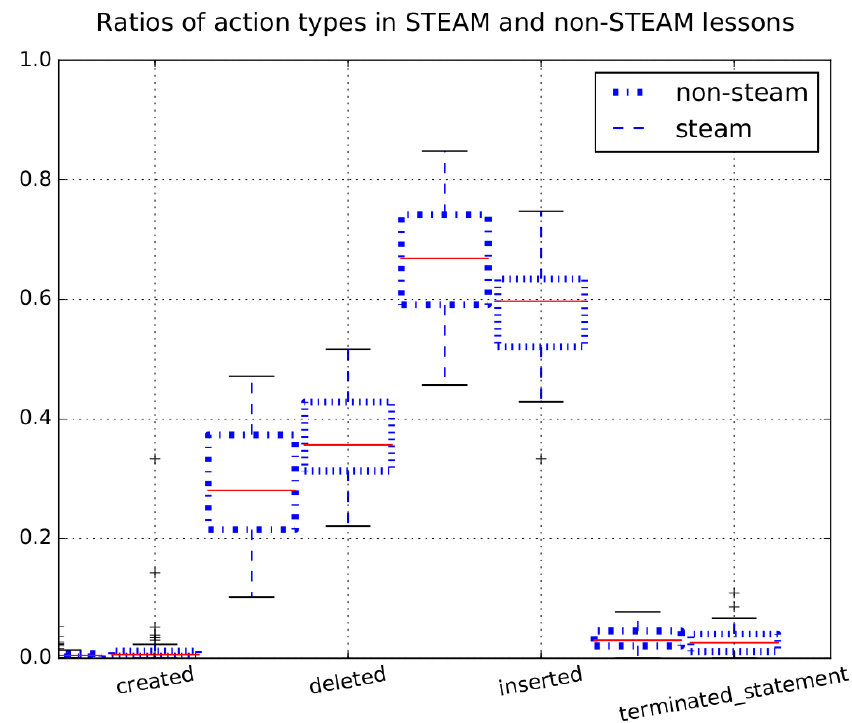
Fig. 8. Ratios of code operation types in STEAM and non-STEAM lessons. Each box shows the range of values for a verb in a lesson type. High up boxes indicate more common actions, box size indicates the range of values